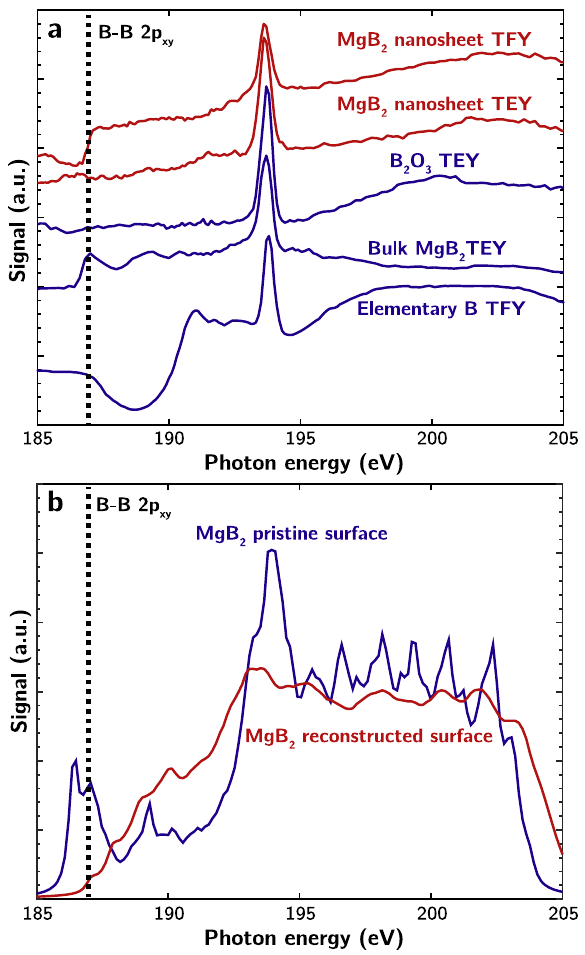
Fig. 5 XAS measurements and simulations of exfoliated MgB 2 NSs. a Boron K-edge TEY (total electron yield; surface-sensitive) and TFY (total fl uorescence yield; more bulk-sensitive) modes of XAS spectra for exfoliated MgB 2 nanosheets, compared to reference spectra for other bulk boron-containing compounds. b Simulated XAS spectra for MgB 2 slabs with pristine or LM4-reconstructed boron surfaces. The decrease in the simulated signal near 203 eV is due to the fi nite number of electronic bands included in the